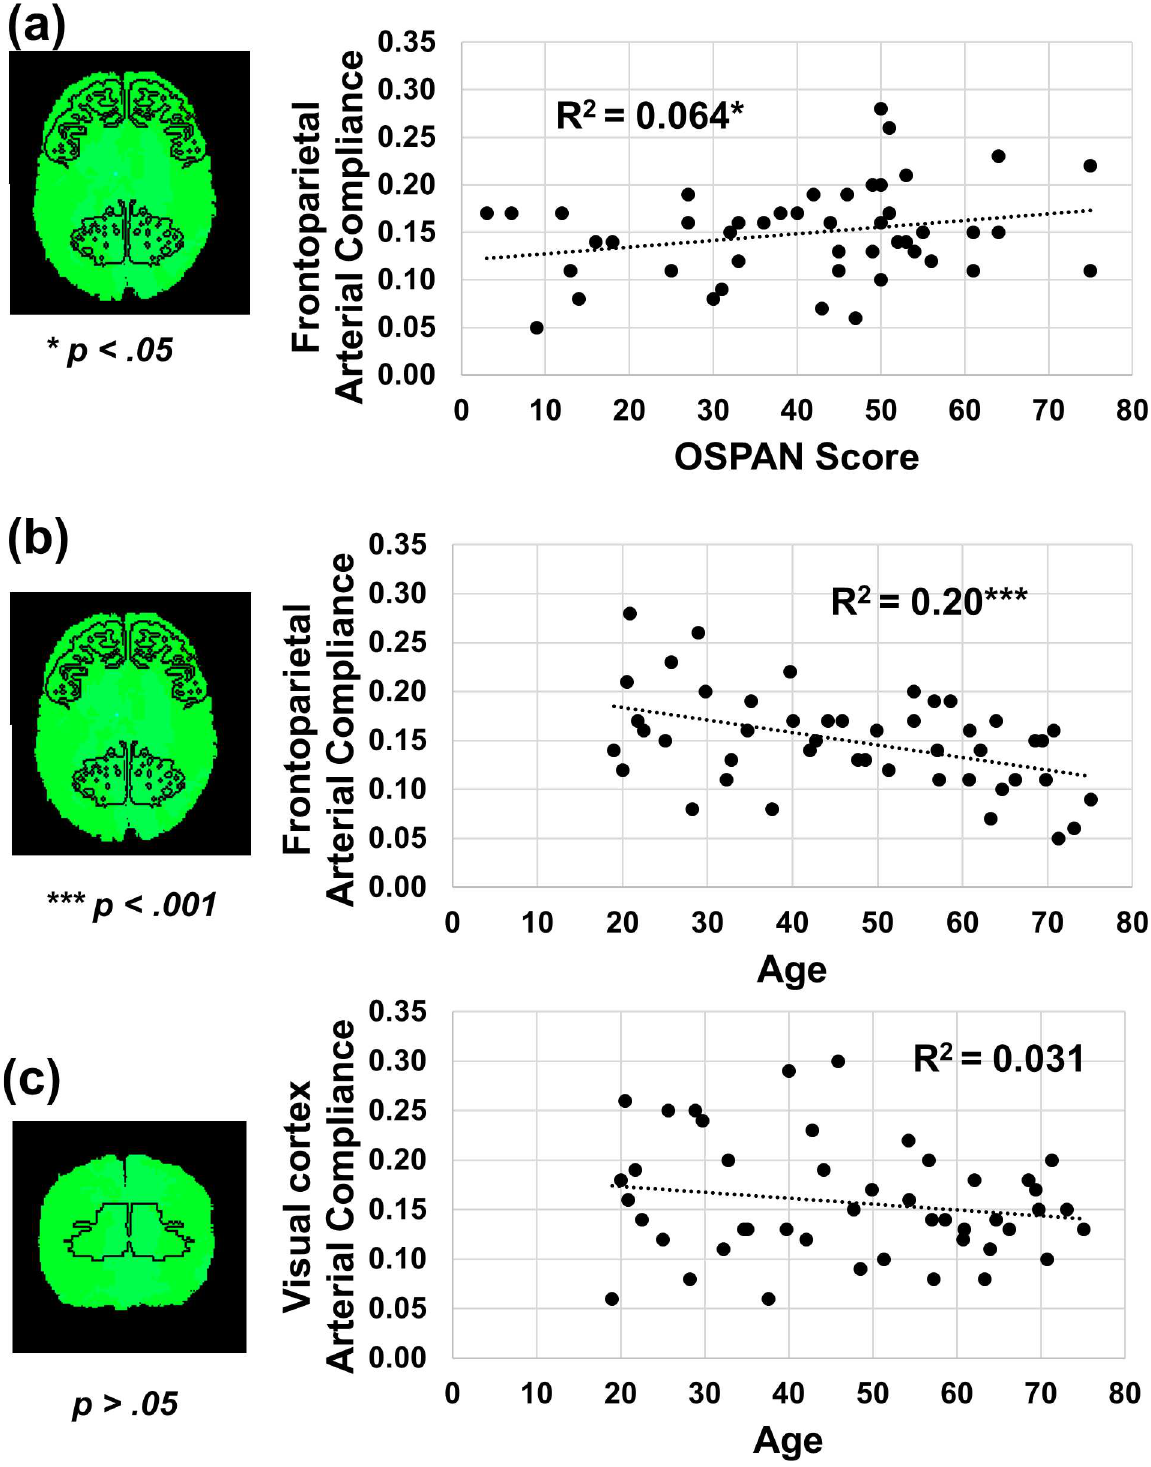
Fig 7. (a) Greater regionalarterial compliancein frontoparietal regions (BA7 and BA9) was associatedwith performance on the OSPAN task. (b) Lower regionalarterial compliancein frontoparietal regions(BA7 and BA9) was also associated with older age. c) Arterial compliancein the visual cortex (BA17 and BA18) was not associatedwith